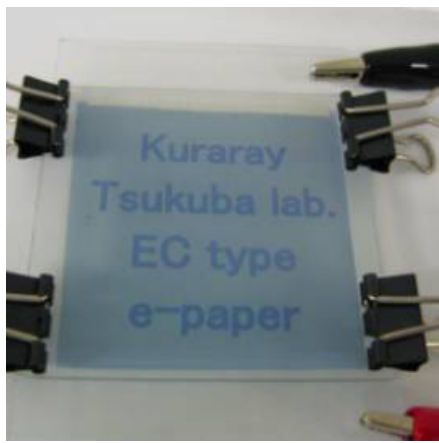
Figure 9. The image of ECD.